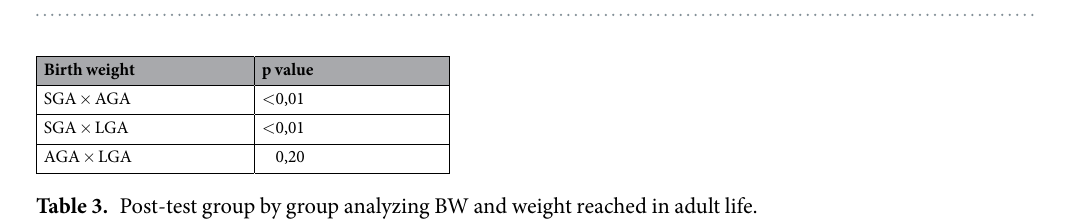
Table 2. Baseline Characteristics of the Patients. SGA, small for gestational age; AGA adequate for gestational age; LGA, large for gestational age; PCOS, polycystic ovary syndrome.